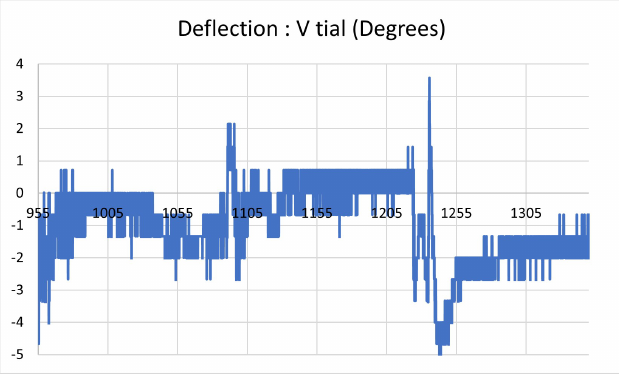
Figure 8. V-Tail Defection: Flight